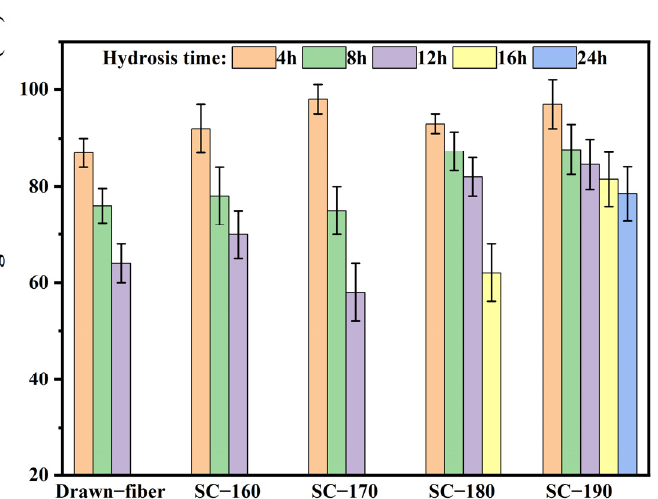
Figure 8. Monofilament strength retention rate of drawn − fiber and SC − PLA fiber hydrolyzed for different times.